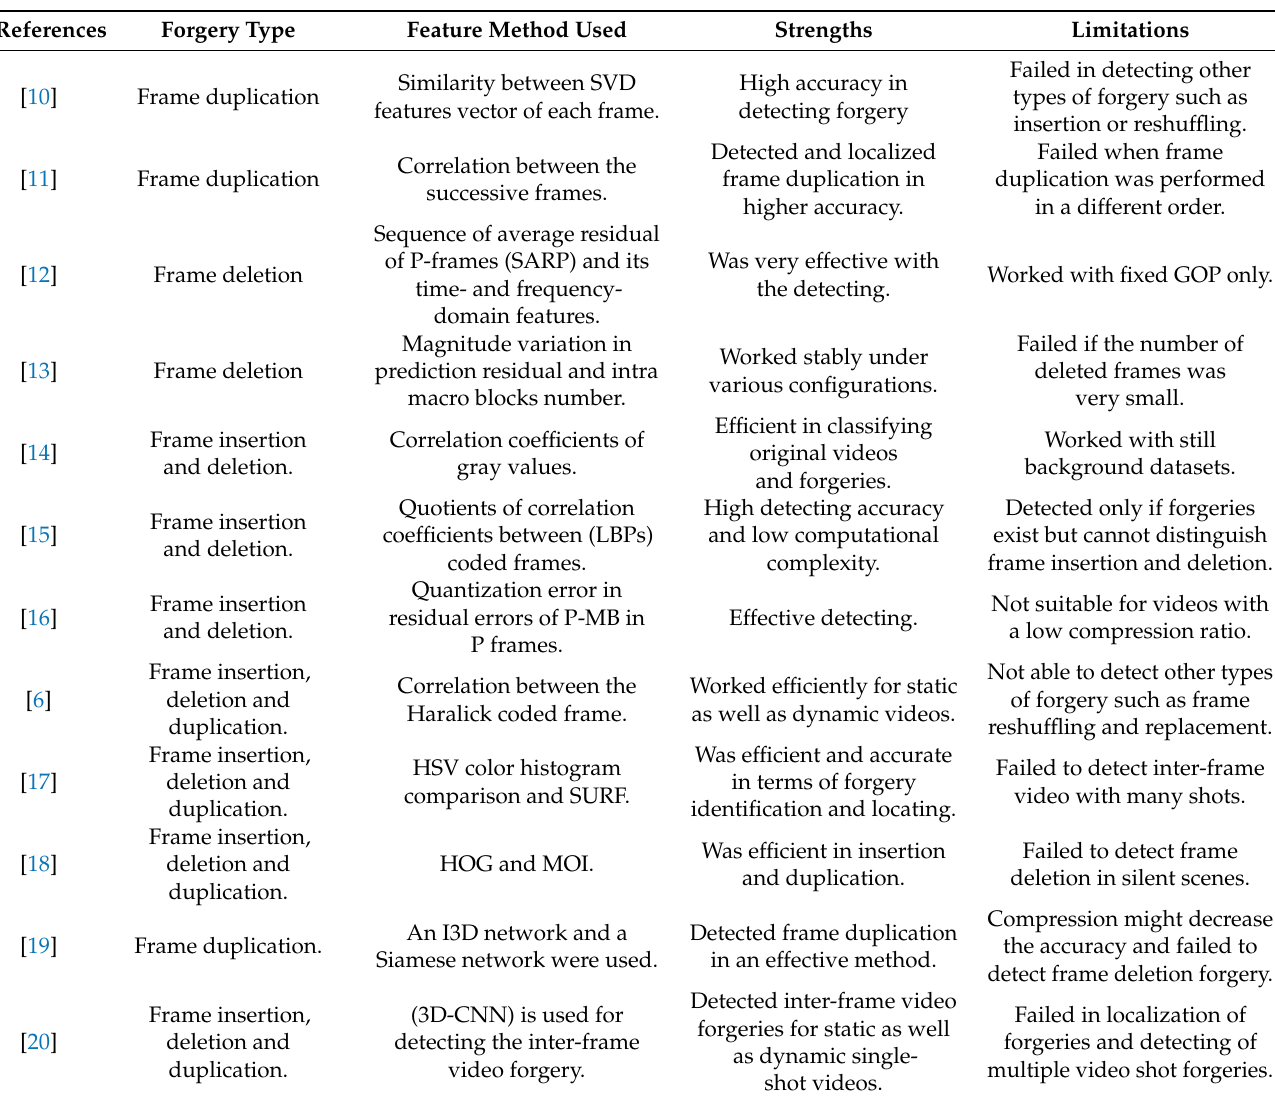
Table 1. Video forgery detecting